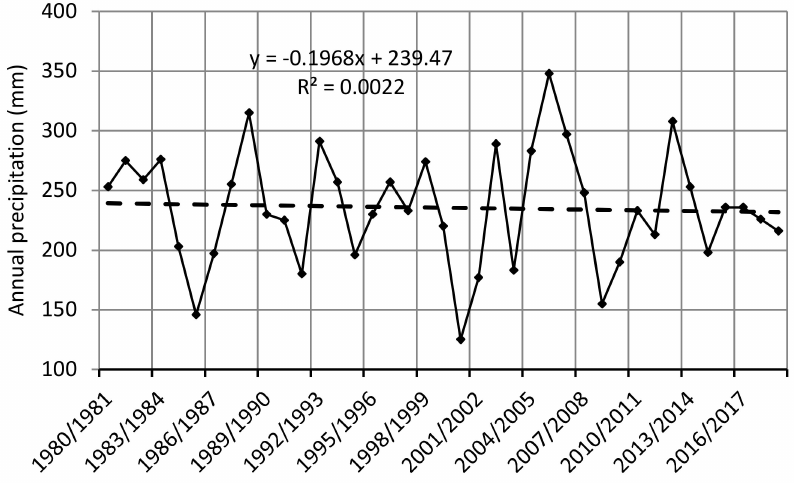
Figure 3. Long-term variability (1980–2019) of the annual air precipitation total in Yakutsk (mm). The linear trend is shown by the dotted